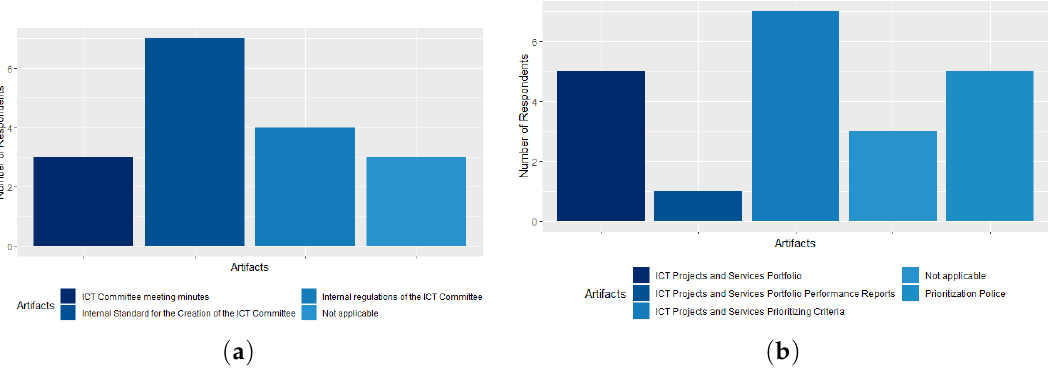
Figure 6. ( a ) The ICT Committee process artifacts; ( b ) the ICT Projects and Services Portfolio process artifacts.